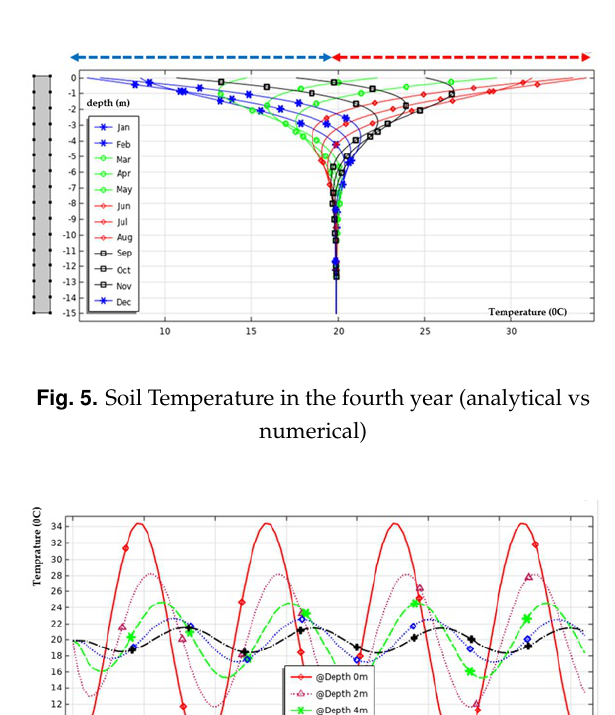
Fig. 4. Soil temperature in the first three years (analytical vs numerical)